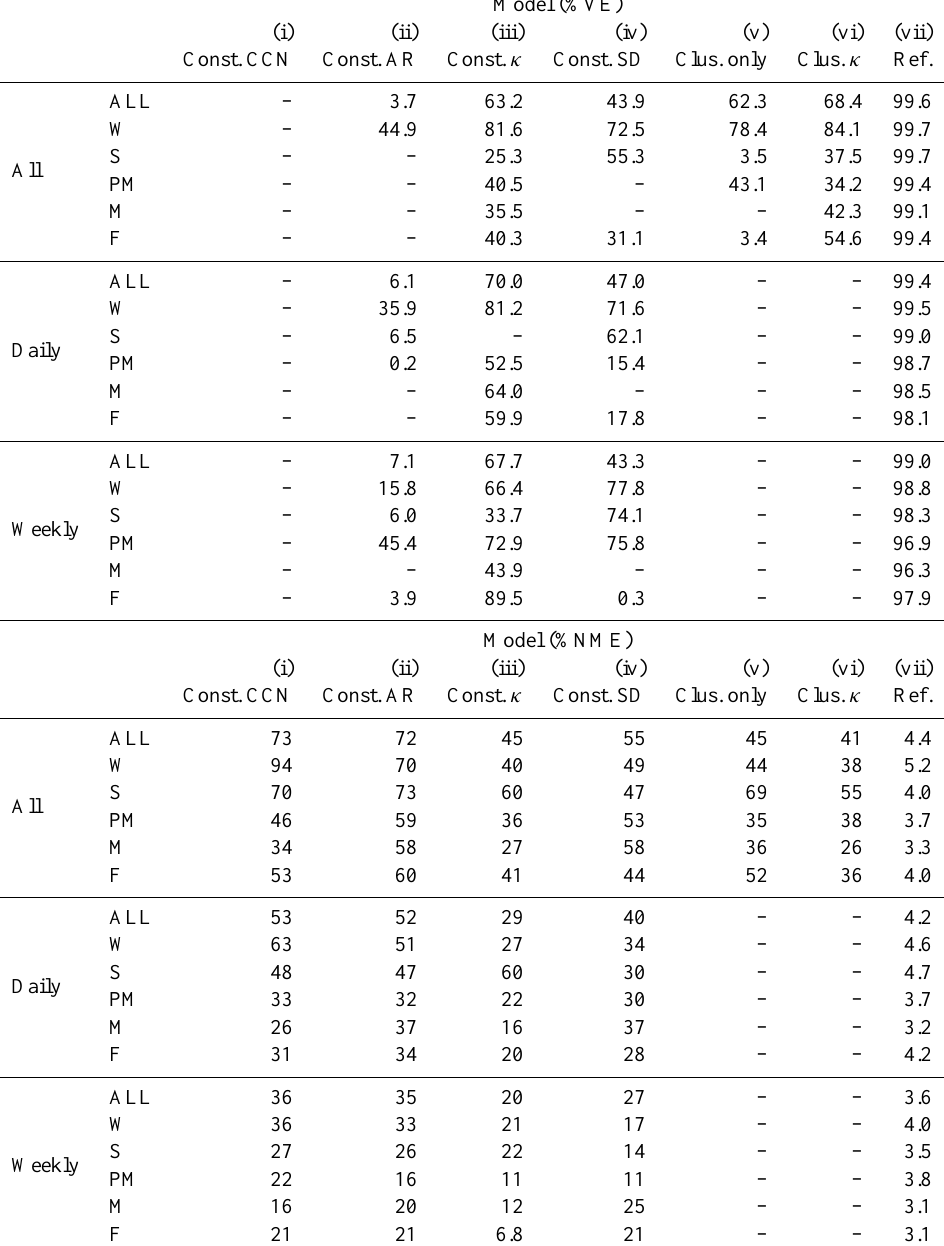
Table 4. Closure model performance as quantified by variance explained (top) and normalized mean error (bottom). Models (i)–(iv) include holding constant either CCN, activation ratio (AR), κ , or size distribution (SD). Model (v) uses the cluster properties and associations (see Fig. 5 and Table 3), model (vi) uses the same assumptions as model (iii) except that κ is determined from cluster associations, and model (vii) is a reconstruction for reference only. A dash (–) indicates that the result is not available or performed so poorly it cannot be quantified by the